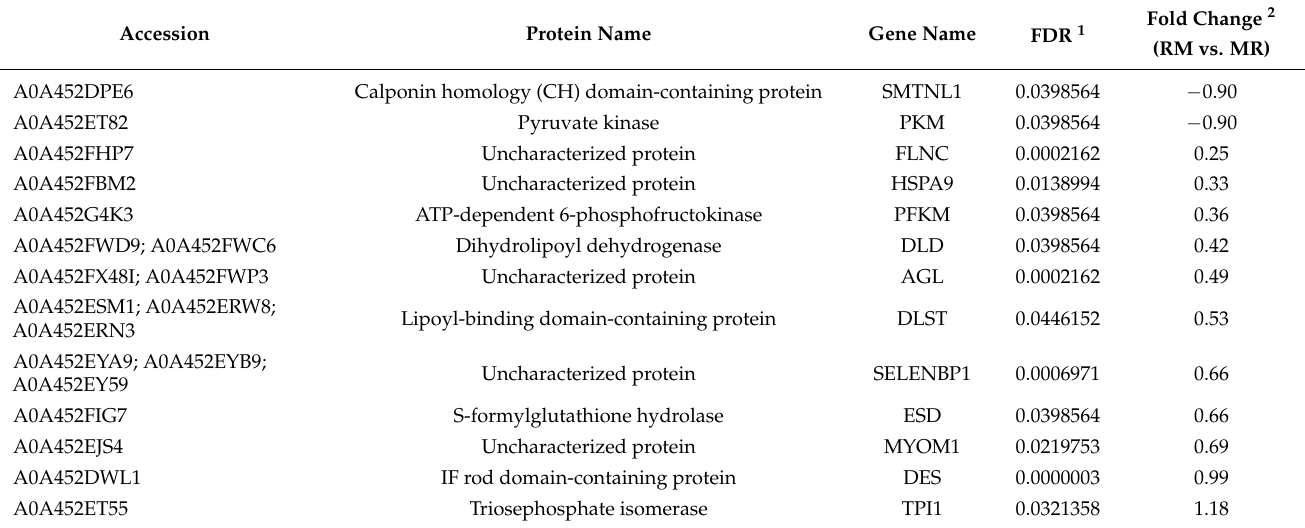
Figure 2. Volcano plot comparing protein abundance fold changes (FC) between treatments (ratio RM/MR). Differentially abundant proteins (DAPs; FDR < 0.05) are highlighted in red and green. DAPs highlighted in green are upregulated and DAPs highlighted in red are downregulated. The black squares represent the non-significant proteins (FDR > 0.05). Table 1. Differentially abundant proteins (DAPs) in the skeletal muscle of the